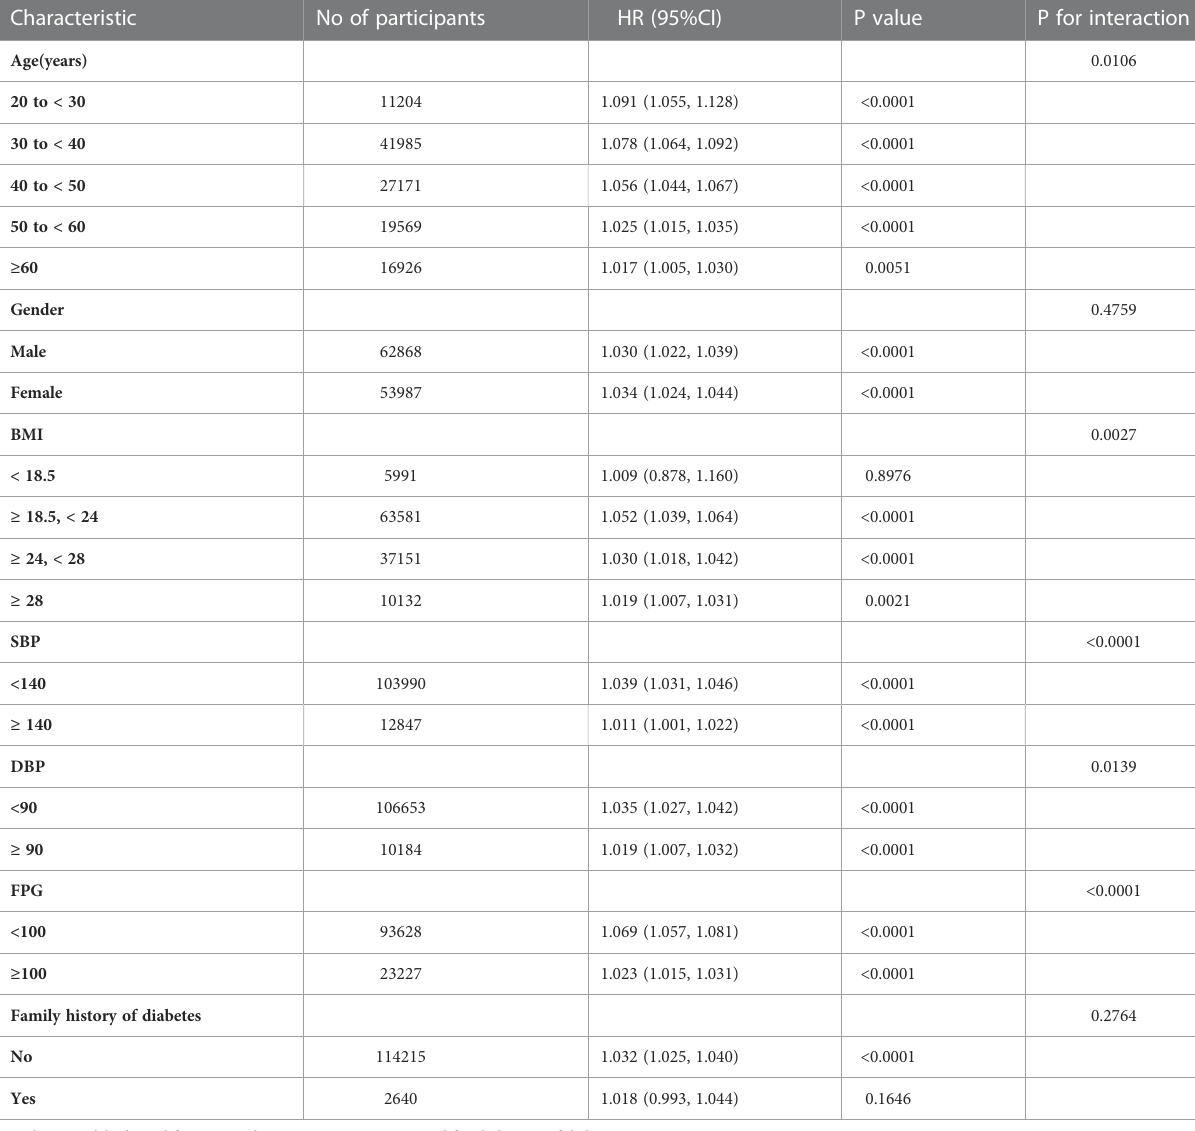
TABLE 5 Effect size of METS-IR on diabetes in prespeci fi ed and exploratory subgroups.